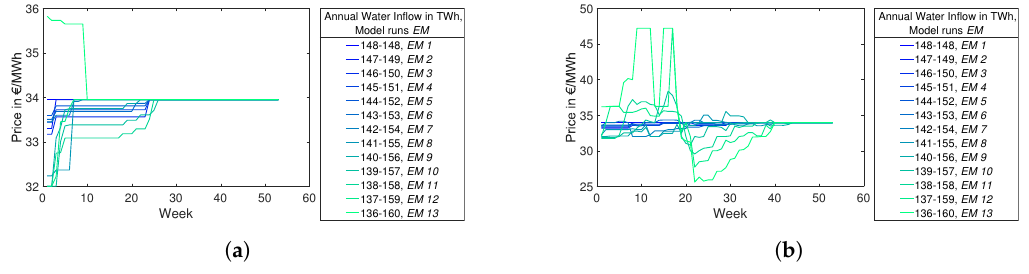
Figure 10. Reasons for seasonal price structures. ( a ) impact of uncertainty on electricity prices: constant profiles (water inflow, demand, export, wind, import/primary energy prices); ( b ) impact of uncertainty on electricity prices: constant primary energy price